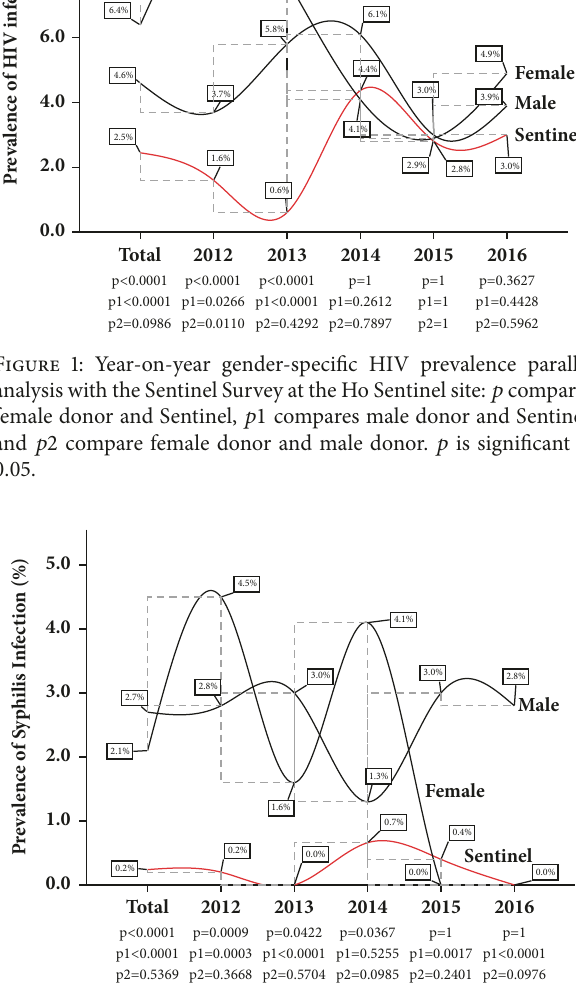
Figure 2: Year-on-year gender-specific Syphilis parallel analysis with the Sentinel Survey at the Ho Sentinel site: 𝑝 compares female donor and Sentinel, 𝑝1 compares male donor and Sentinel, and 𝑝2 compare female donor and male donor. 𝑝 is significant at